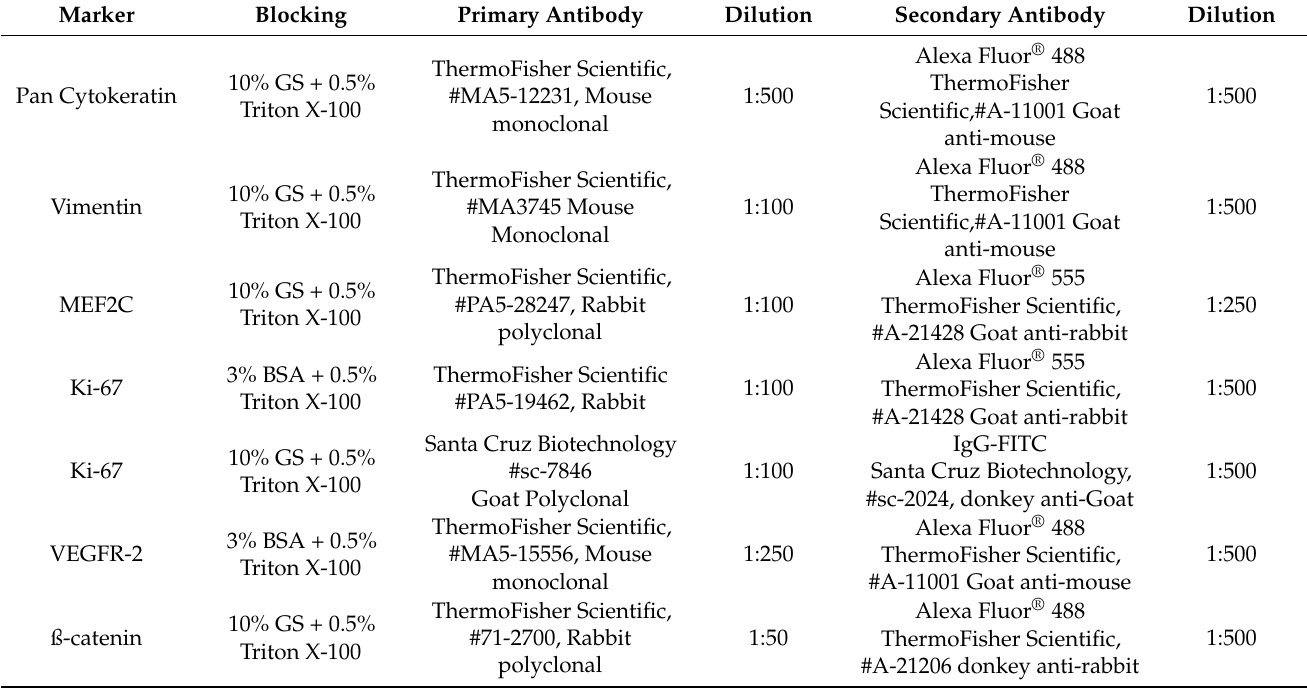
Table 3. Summary of the antibodies and experimental conditions used in immunofluorescence analysis.